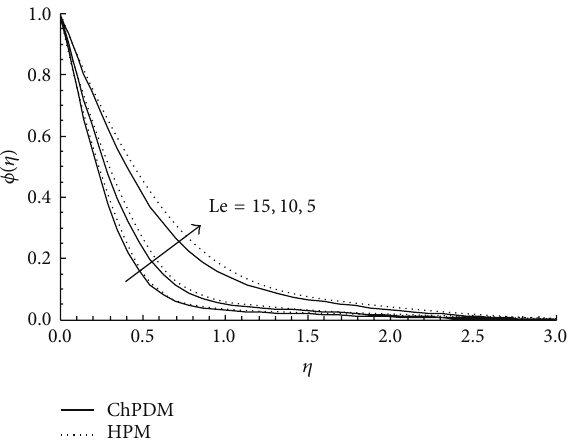
Figure 3: Comparison of ChPDM (solid) and HPM (dotted) for the effect of the buoyancy ratio parameter (𝑁 𝑟 ) and the mixed convection parameter ( Ra 𝑥 / Pe 𝑥 ) on the temperature distribution = 0.5 , 𝑁 = 0.5 , Le = 10 , and 𝛼 = 𝜋/6 . 𝜃(𝜂) at 𝑁 𝑏 𝑡